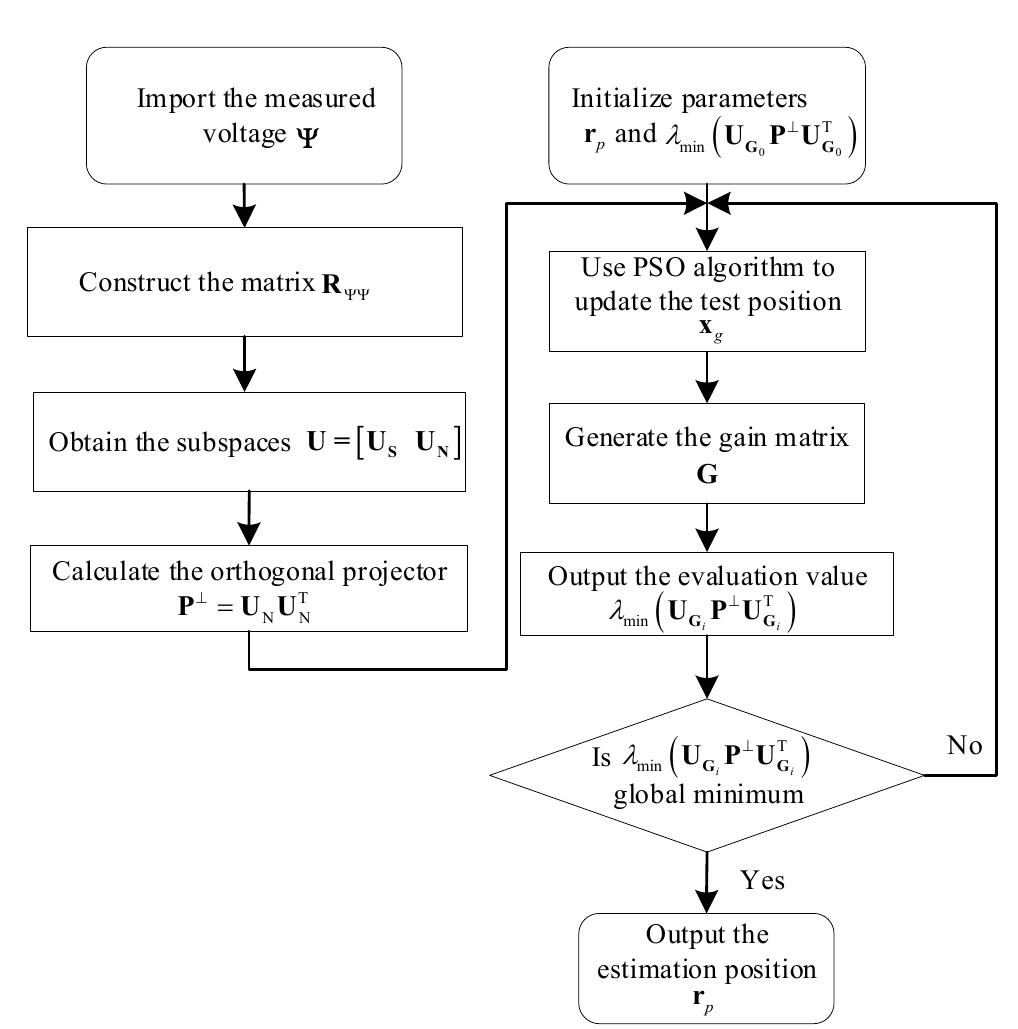
Figure 5. The flowchart of the proposed localization